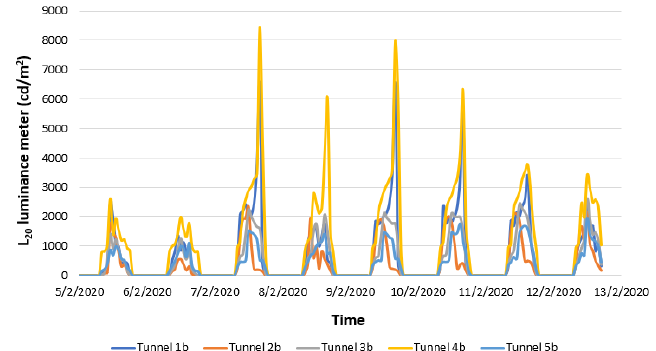
Figure 6. Signal from SCADA due to daylight variation (eight days) for the examined tunnels in the lanes leading to Lamia (Tunnels 1b, 2b, 3b, 4b, and 5b). Table 11. Comparison of the energy consumption (kWh) between the switching scenarios A and B for the period from 5 February, 2020 to 13 February, 2020. Lighting Tunnel